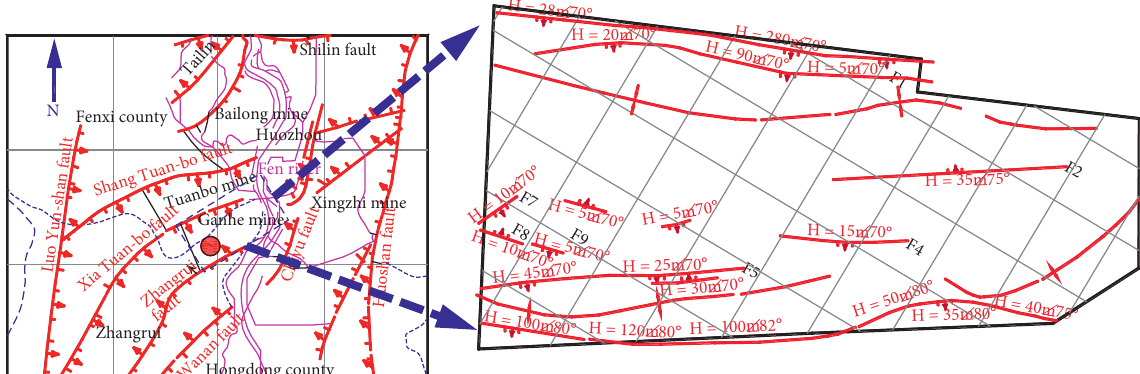
Figure 2: Geological structures of the Ganhe coal